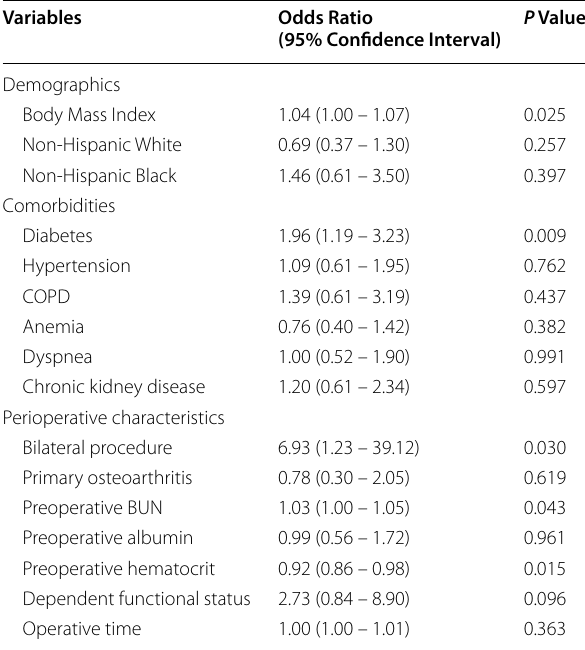
Table 3 Risk Factors for Acute Kidney Injury